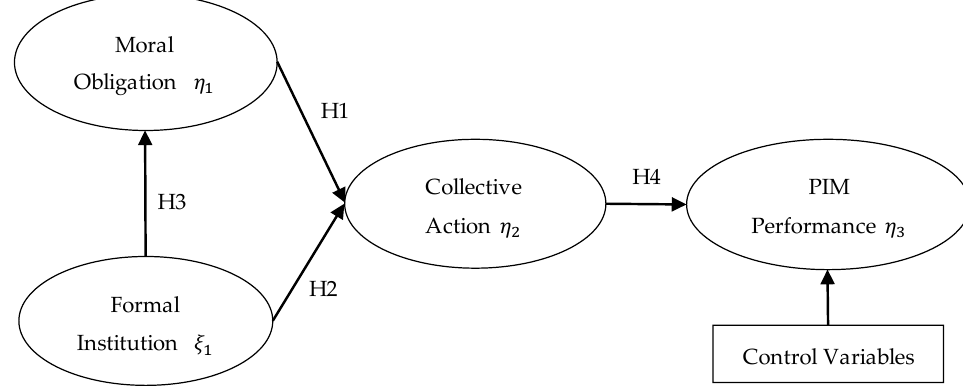
Figure 2. Theoretical model and research hypothesis.